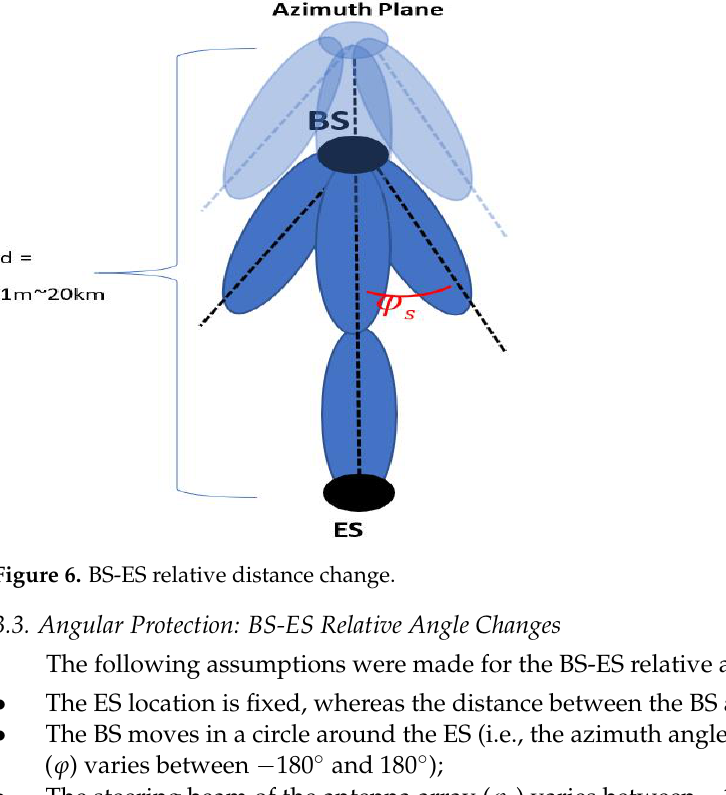
Figure 5. Beam angles that should be shut off: RMa ( a ), UMa ( b ) and UMi ( c ) LOS and NLOS.